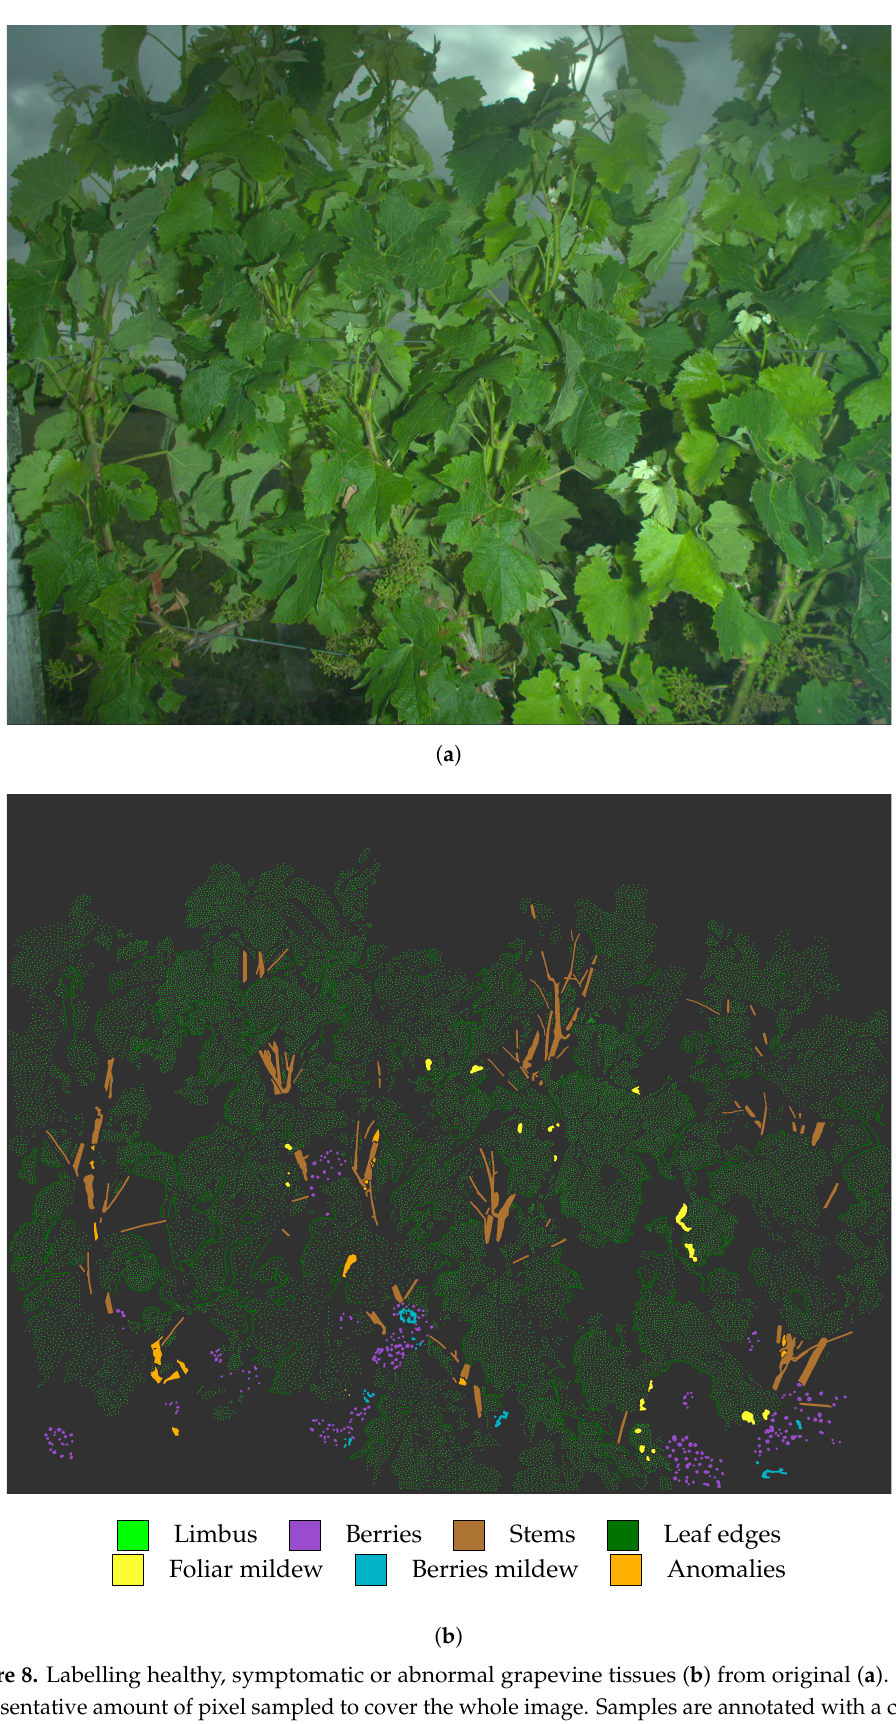
Figure 8. Labelling healthy, symptomatic or abnormal grapevine tissues ( b ) from original ( a ). ( b ) A representative amount of pixel sampled to cover the whole image. Samples are annotated with a colour code corresponding to their class according to